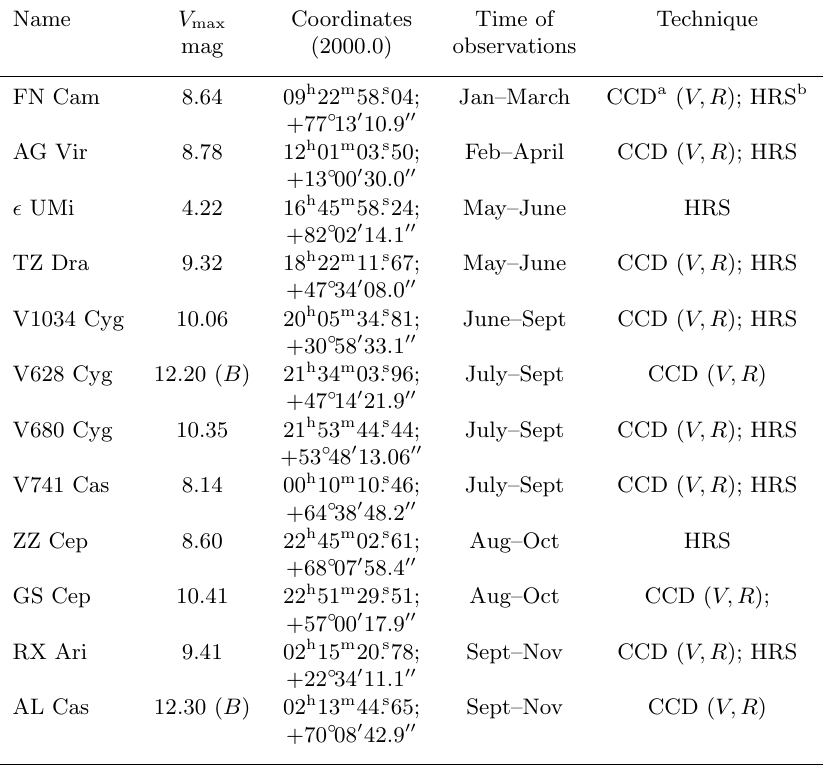
Table 1. The list of program